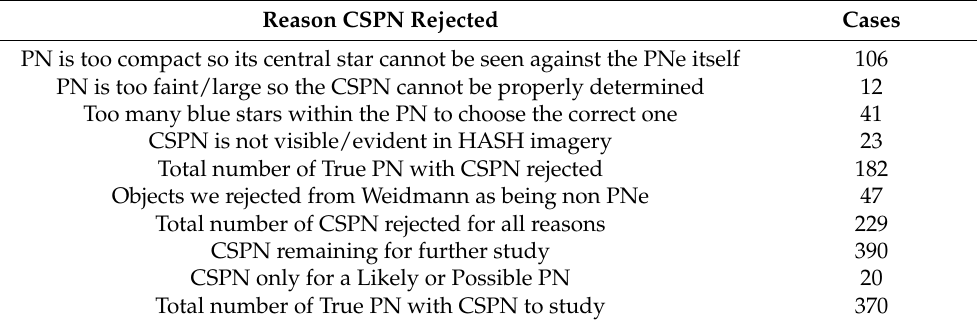
Table 1. This table provides the results of our examination of all 619 CSPN listed in [2] based on available HASH imagery, giving the main reason we cannot confirm the CSPN identification. Reason CSPN Rejected Cases PN is too compact so its central star cannot be seen against the PNe itself 106 PN is too faint/large so the CSPN cannot be properly determined 12 Too many blue stars within the PN to choose the correct one 41 CSPN is not visible/evident in HASH imagery 23 Total number of True PN with CSPN rejected 182 Objects we rejected from Weidmann as being non PNe 47 Total number of CSPN rejected for all reasons 229 CSPN remaining for further study 390 CSPN only for a Likely or Possible PN 20 Total number of True PN with CSPN to study